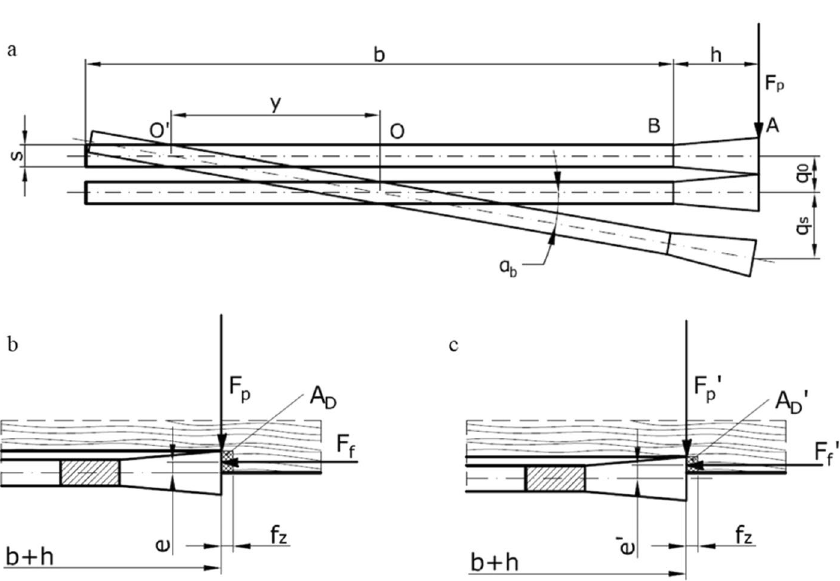
Figure 10. The transverse displacement of the saw blade under the action of the thrust force F p , where: q 0 is the displacement resulting from the deflection of the saw blade corresponding to the displacement under the action of the F p force applied at point O ; q s is the torsional displacement of the blade; h is the tooth height; b is the blade width; s is the blade thickness; y is the displacement of the pivotal point relative to the middle of blade O ; α b